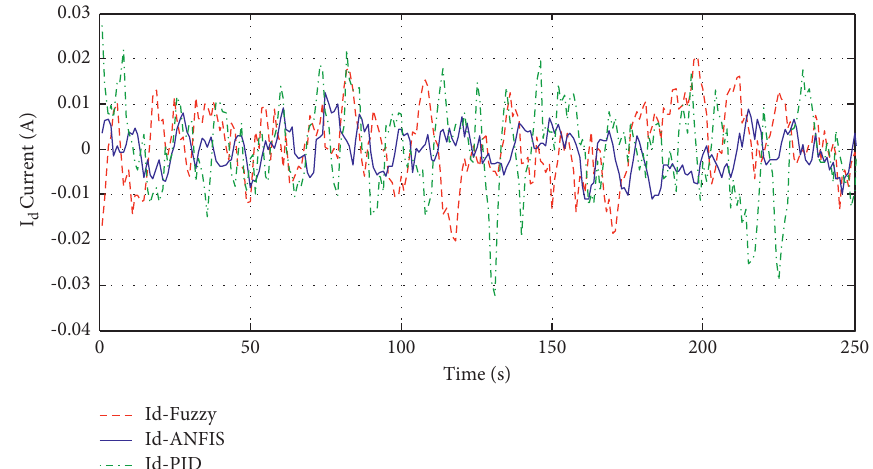
Figure 17: d-axis current of all three ANFIS, Fuzzy, and PID controllers, in “step” reference input mode.